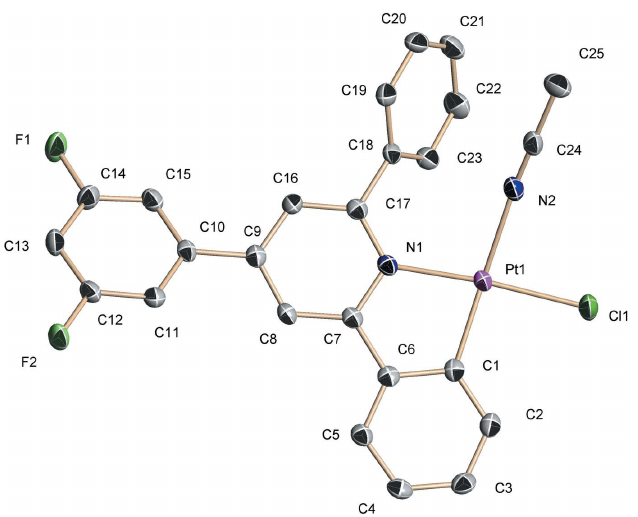
Figure 1 The molecular structure of the title compound, with the atom-numbering scheme. Displacement ellipsoids are drawn at the 30% probability level; H atoms were omitted for clarity.